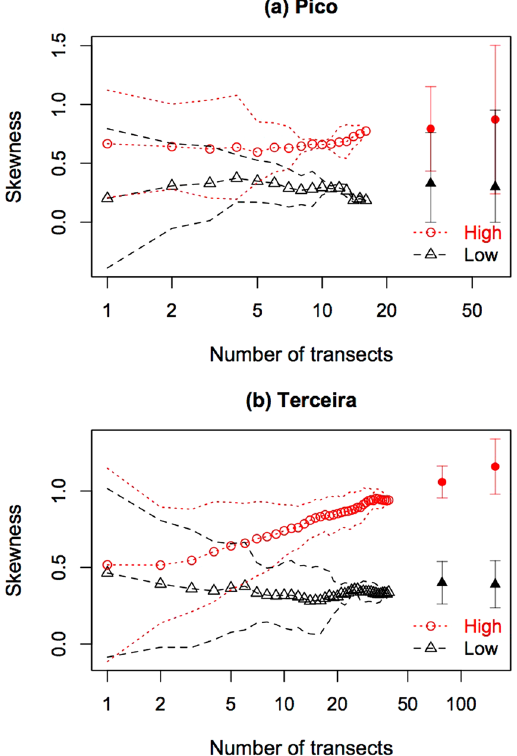
Figure 4. Trend of the skewness (third standardized moment) of the SAD as a function of the number of transects. The symbols in red are for high- and in black for low- dispersal ability arthropod species groups of Terceira and Pico islands. The circles and triangles correspond to the mean values of the skewness calculated from the SAD obtained from all possible addition of transects using the concentric procedure as explained in the Methods. The dot and dashed lines correspond to 2 standard deviation confidence intervals. The two rightmost bold dots are the skewness estimated from extrapolated SADs and the arrow bars correspond to two standard